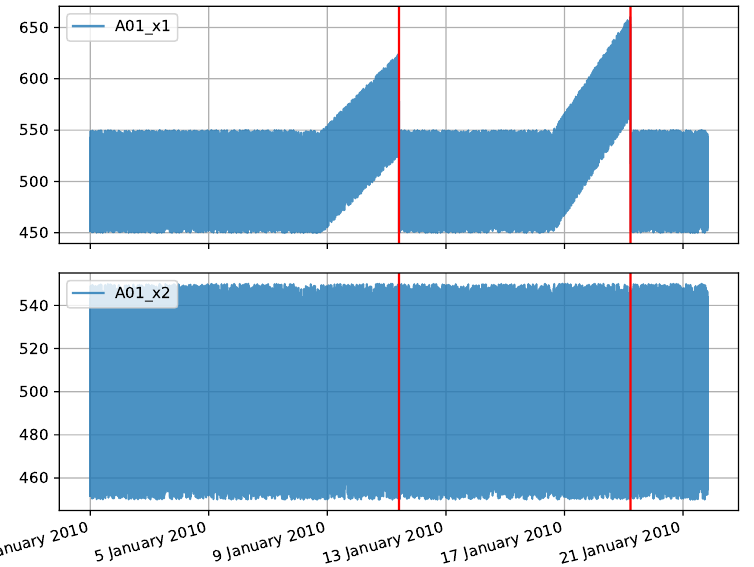
Figure A1. Plots of values for the synthetic data set consisting of x 1 (red lines indicate failure locations) and x 2